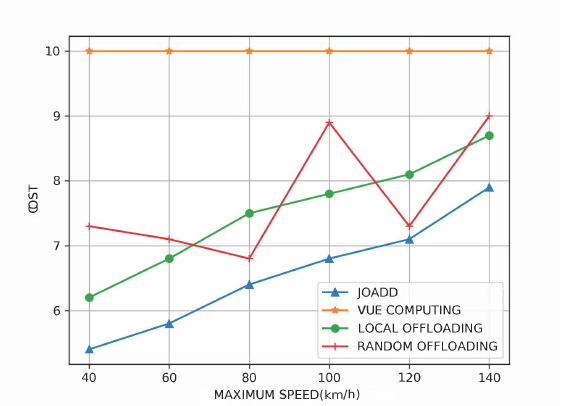
Figure 9. The effect on cost of the different speeds of